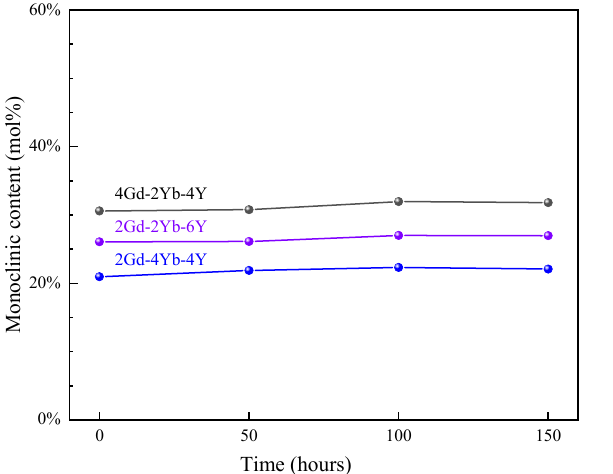
Figure 2. M phase contents of 2Gd-2Yb-6Y, 4Gd-2Yb-4Y and 2Gd-4Yb-4Y powders with time at 1300 °C.